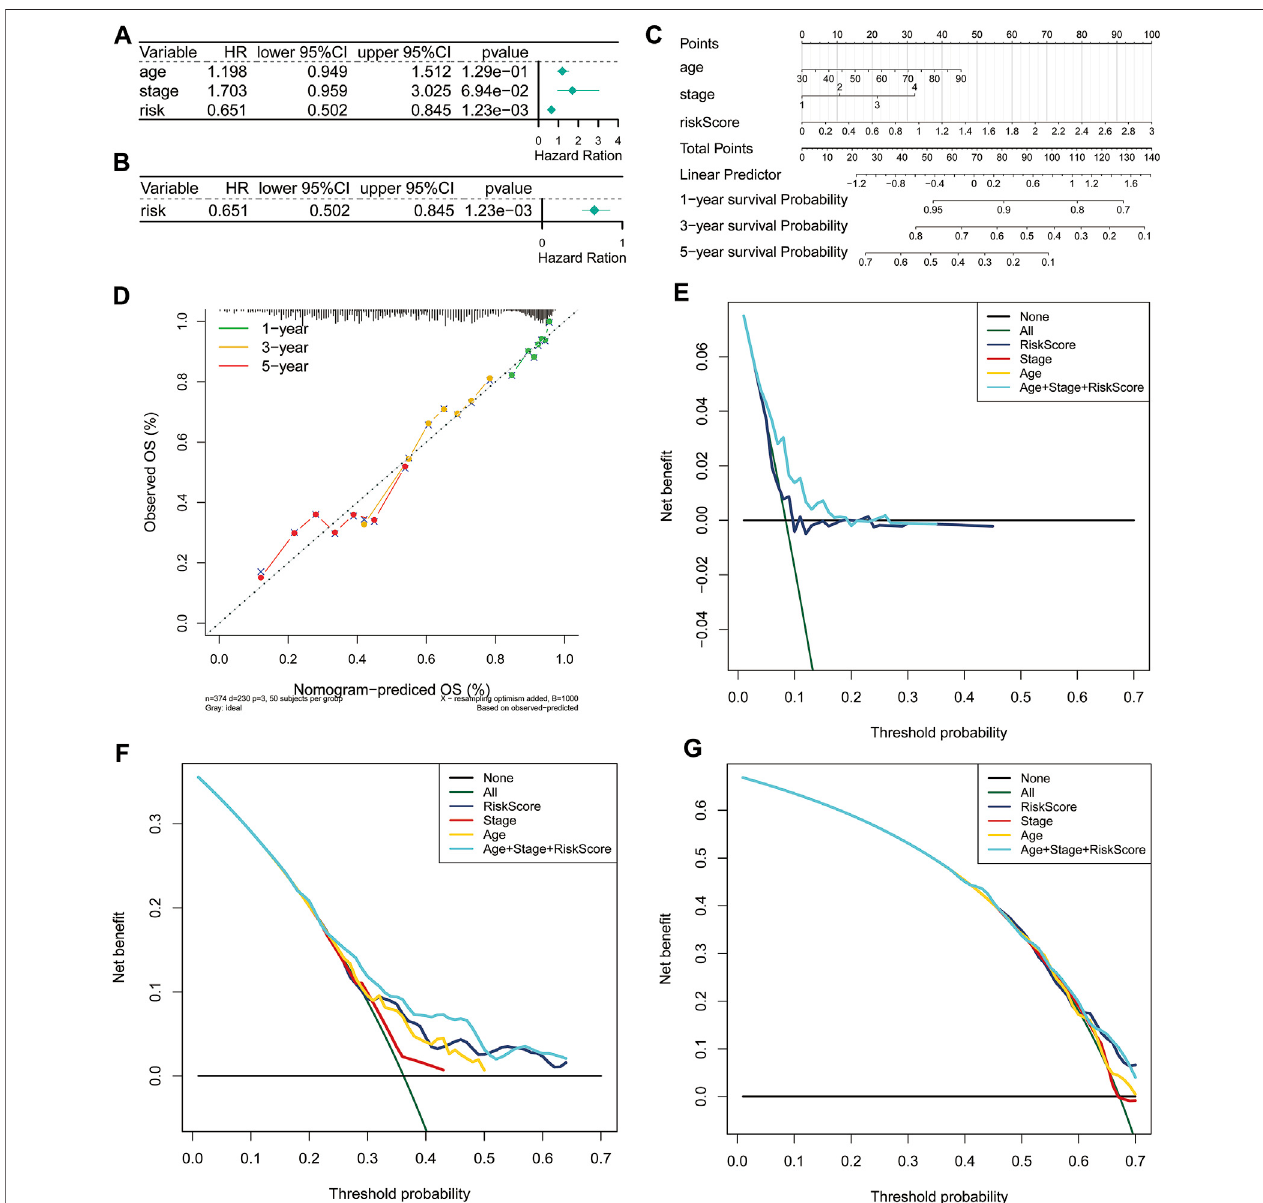
FIGURE 3 | Independent prognostic value of the risk score based on the 3-gene signature . Forest plot of univariate (A) and multivariate (B) Cox proportional hazards regression analysis. (C) A nomogram based on risk score and clinical indicators for predicting 1-, 3-, and 5-year OS of ovarian cancer patients in TCGA cohort. (D) Calibration plot of nomogram for predicting probabilities of 1-year, 3-year, and 5-year OS of patients. The dotted line indicates actual survival. (E – G) Decision curve analysisshowstheexpectednetbene fi tsat1- (E) ,3- (F) ,and5-year (G) basedonthenomogrampredictionatdifferentthresholdprobabilitiesintheTCGAdataset. None: assume an event will occur in no patients (horizontal solid line); All: assume an event will occur in all patients (green dash line). OS, overall survival.